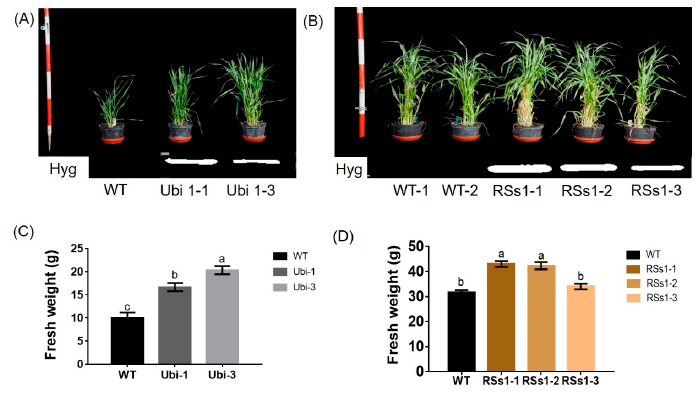
Figure 2. Phenotypes of all barley plants in pot experiments during the vegetative growth stage. ( A ) The phenotypes and ( C ) fresh weight of WT and Ubi-1 / 2 / 3 transgenic lines. ( B ) The phenotypes and ( D ) fresh weight of WT and RSs1-1 / 2 / 3 transgenic lines. Di ff erent letters indicate a significant di ff erence between overexpression transgenic lines and WT ( p < 0.05, one-way ANOVA). Error bars: standard error ( n = 4